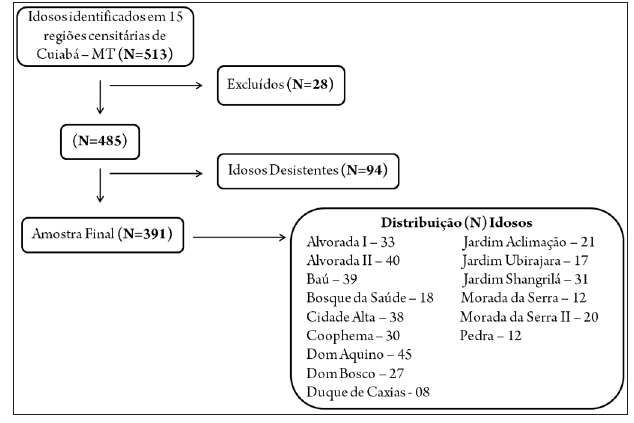
Figura 1. Fluxograma da amostra do estudo